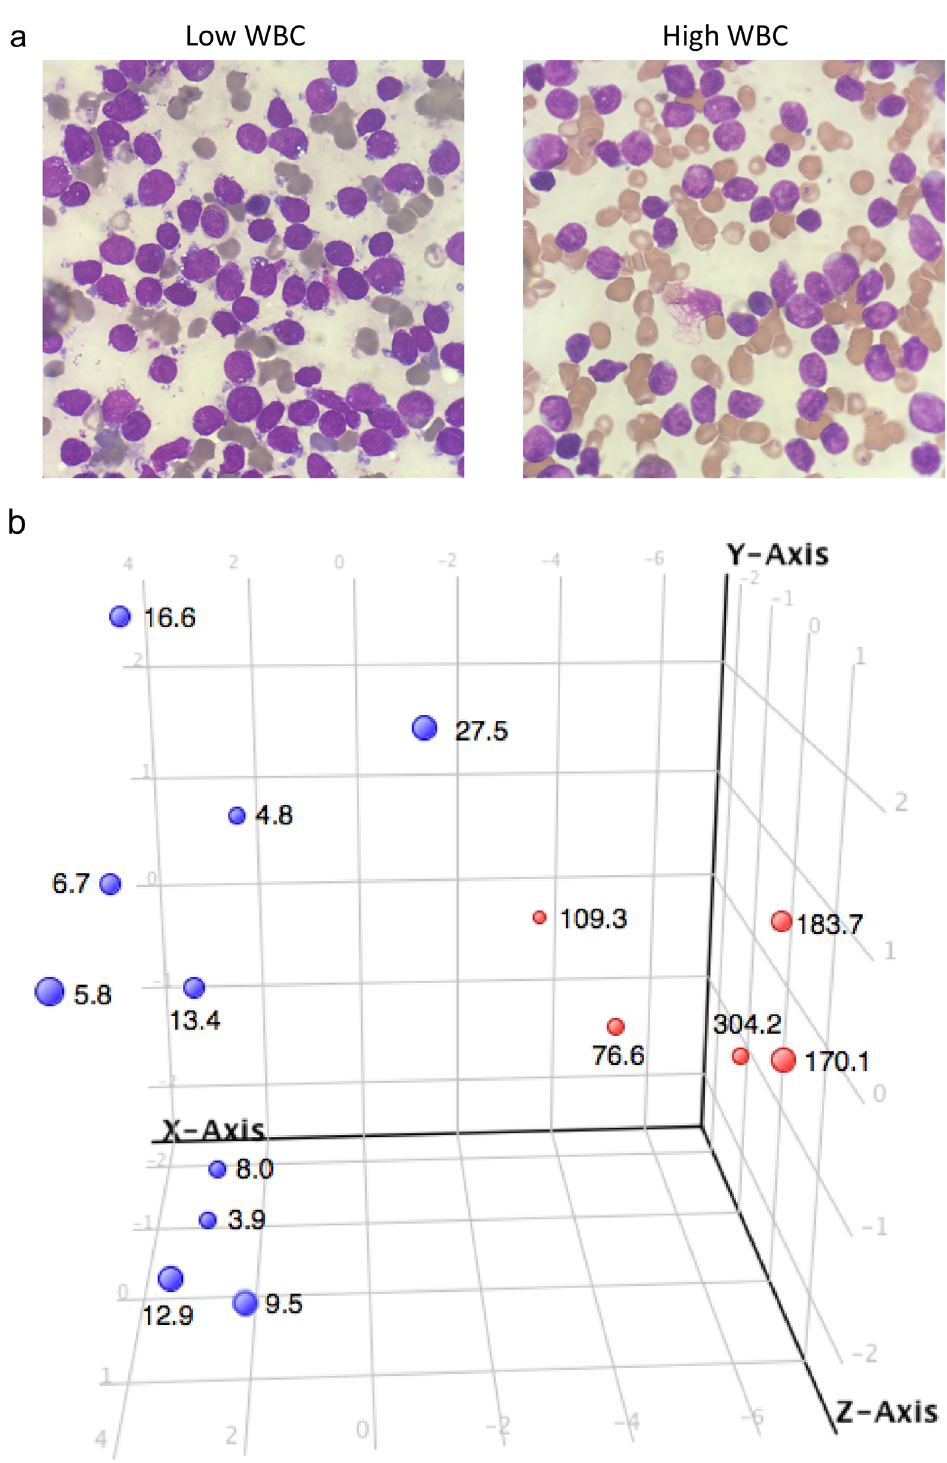
Fig 1. Differentially expressed features between high and low WBC count ETV6-RUNX1 -positive patient samples. ( a ) Diagnostic bone marrow aspiration samples from a patient with low (left side) and high (right side) WBC count at initial presentation were Wright-Giesma stained. ( b ) Total RNAs were isolated from 15 ETV6-RUNX1 -positive patient samples. Aminyoallyl-aRNA was produced using 100 ng total RNA. Gene expression microarray was performed using the Agilent 60-mer oligo array (Human Gene Expression